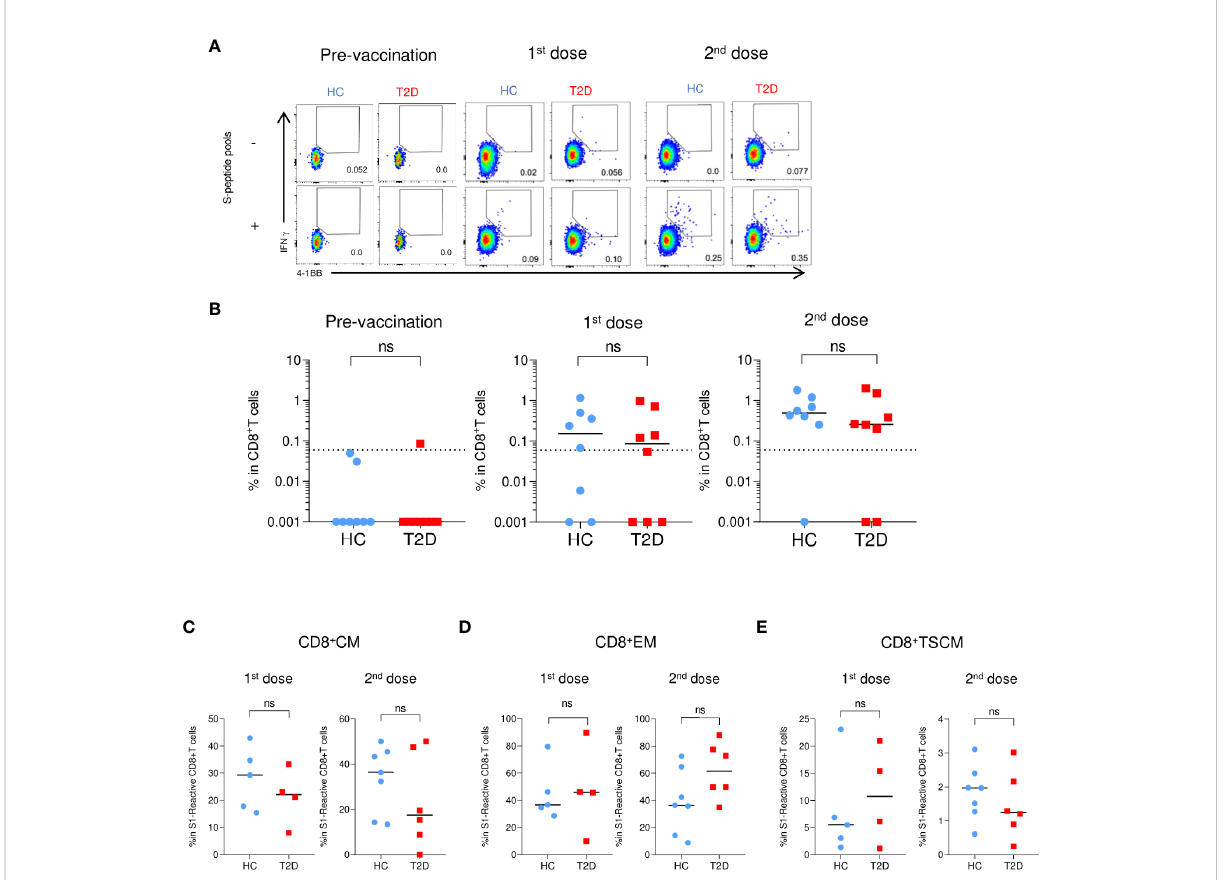
FIGURE 5 S1-reactive CD8 + T Cell responses shortly after BNT162b2 vaccination. PBMCs collected from BNT162b2 vaccinees for time course analysis were stimulated with S1 peptide pools (n=8/group). (A) Representative fl ow cytometry plots depicting the gating of IFN g + 4-1BB + (gating) to identify antigen-speci fi c S1-reactive CD8 + cells following peptide stimulation. Dotted line represents the limit of detection. (B) Proportions of S1-reactive CD8 + T cells. (C-E) Proportions of memory T cell subsets in S1-reactive CD8 + T cells (n=4-7/group). (C) central memory (CM), CD45RA - CCR7 + . (D) effector memory (EM), CD45RA - CCR7 - . (E) T stem cell memory (TSCM), CCR7 + CD45RA + CD27 + CD95 + . Data shown are median and each symbol represents an individual (n=4-7/group) (B-E) . ns: not signi fi